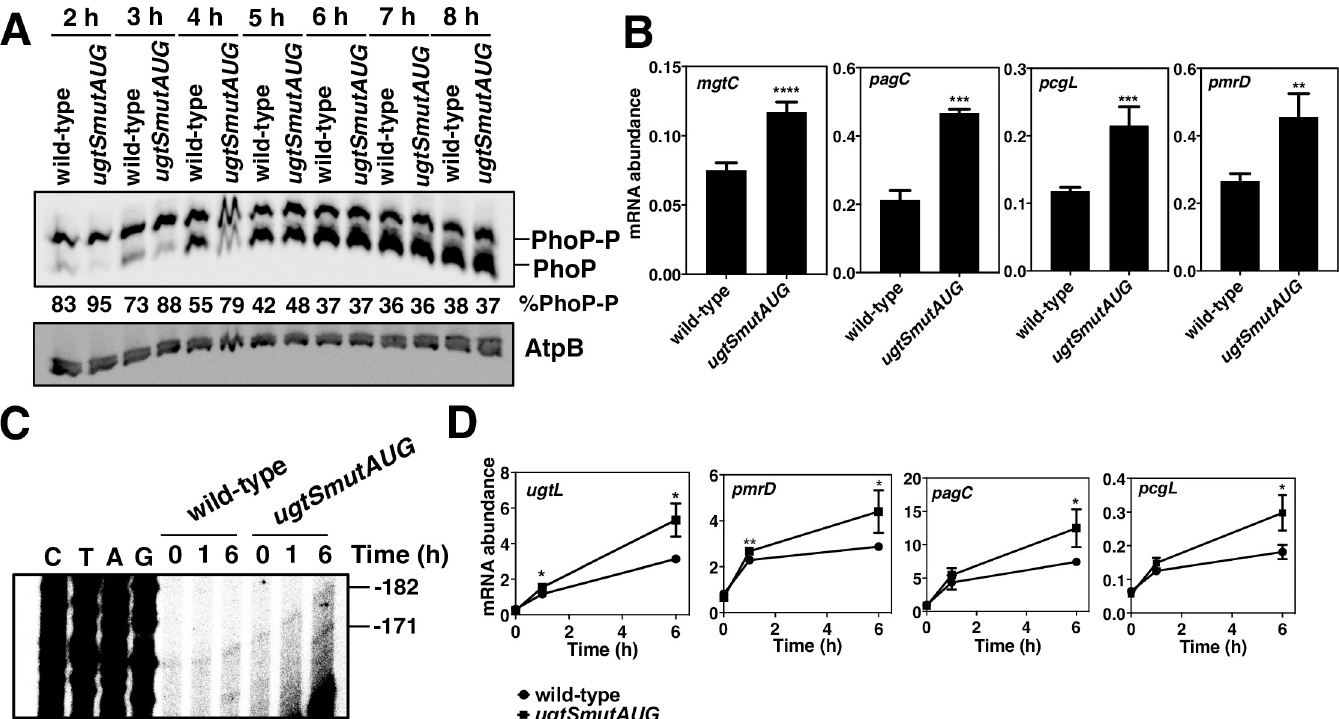
Fig 6. UgtS modulates the kinetics of PhoP activation in acidic pH conditions and inside macrophages. (A) Western blot analysis of extracts prepared from wild-type (14028s) and ugtSmutAUG (HS1119) S . Typhimurium grown in N-minimal acidic pH medium (pH 4.9, 1 mM MgCl 2 ) for the indicated times. Samples were run on Phos-tag gels analyzed with antibodies directed to the PhoP and AtpB proteins. Numbers under the blots indicate the percentage of phosphorylated PhoP (PhoP-P). Data are representative of three independent experiments, which gave similar results. (B) Abundance of mgtC , pagC , pcgL , and pmrD transcripts in wild-type (14028s) and ugtSmutAUG (HS1119) S . Typhimurium grown in N-minimal acidic pH medium (pH 4.9, 1 mM MgCl 2 ) for 4 h (mid-log phase). Transcript abundance values were normalized to the abundance of 16S ribosomal RNA. The mean and SD from at least three independent experiments are shown. �� P < 0.01, ��� P < 0.001, ���� P < 0.0001, two-tailed unpaired t test with ugtSmutAUG vs. wild type. (C) Primer extension analysis of ugtSugtL and ugtSugtL transcripts from wild-type -182 -171 (14028s) and ugtSmutAUG (HS1119) S . Typhimurium harvested from J774A.1 macrophages at the indicated times. Primer extension reaction was carried out on total RNA samples using primer W4469. A gel image with lower exposure is provided as supplementary data (S3 Fig) to better discern the DNA sequencing ladder bands. Data are representative of two independent experiments, which gave similar results. (D) Abundance of ugtL , pmrD , pagC , and pcgL transcripts in wild-type (14028s) and ugtSmutAUG (HS1119) S . Typhimurium inside J774A.1 macrophages at the indicated times. Transcript abundance values were normalized to the abundance of 16S ribosomal RNA. The mean and SD from three independent experiments are shown. � P < 0.05, �� P < 0.01, two-tailed unpaired t test with ugtSmutAUG vs. wild type. The absence of a � indicates no significant difference between mutant and wild type.